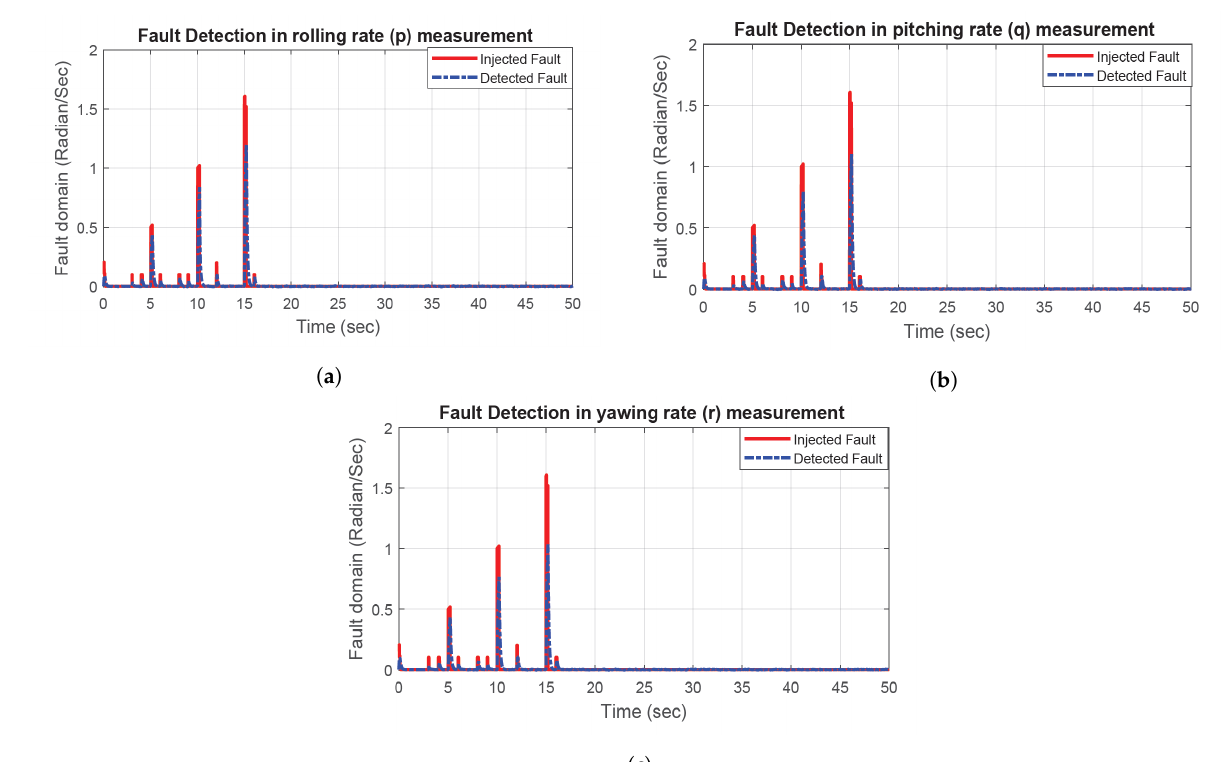
Figure 6. Intermittent fault detection. ( a ) Intermittent fault detection in rolling rate measurement. ( b ) Intermittent fault detection in pitching rate measurement. ( c ) Intermittent fault detection in yawing rate measurement.